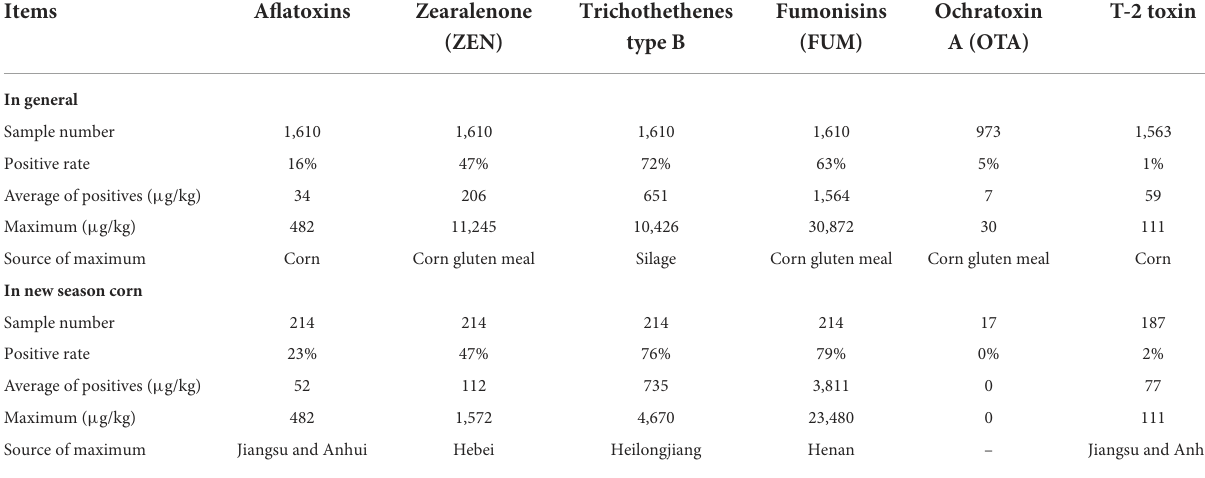
TABLE 1 Mycotoxin contamination in general and in new season corn in China in year